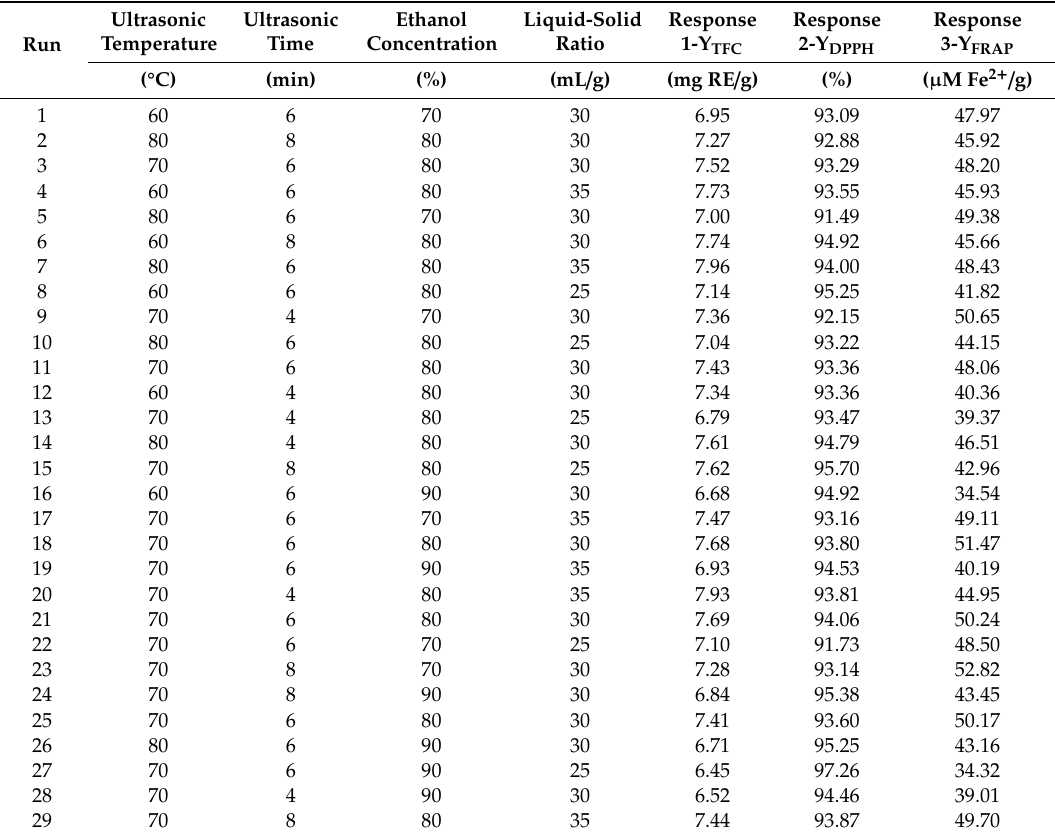
Table 5. Designed experiments and measured responses of response surface